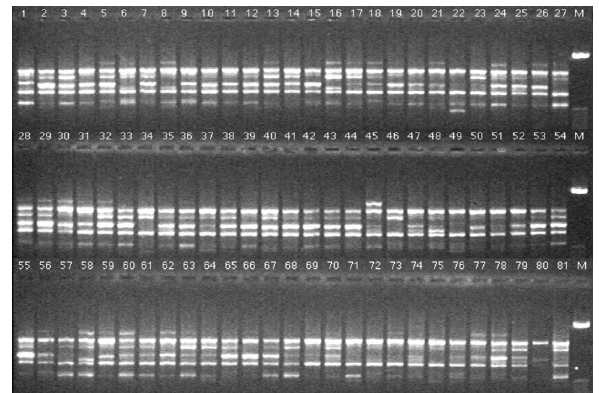
Figure 2 - RAPD gel profile with fragments generated by primer OPW-08 in 81 accessions of maize. Lines 1 through 81 refer to the collection listed in Table 1. M is 100 bp DNA size marker (Gibco